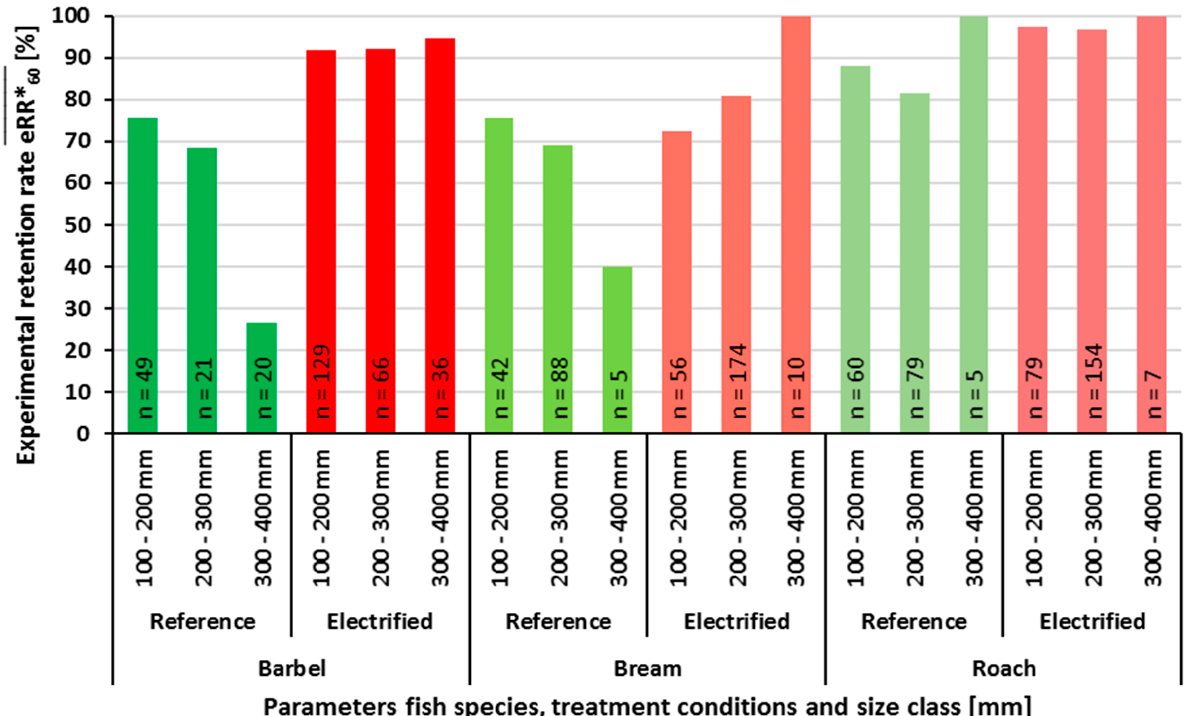
Figure 6. Experimental retention rates eRR (cid:2874)(cid:2868)∗ [%] with exclusion of initial effects based on the number of stocked fish for the species barbel, bream and roach divided by treatment conditions and size classes of 100–200 mm, 200–300 mm and 300–400 mm. Reference conditions indicated in green tones, treatment conditions in red tones.